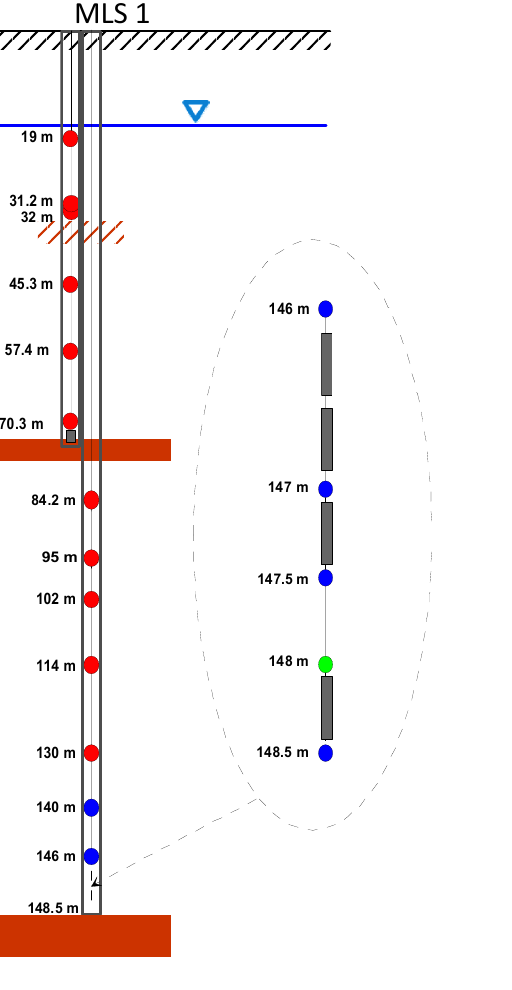
Fig. 3. Depth in meters below ground level (mb.g.l.) showing the positioning of the multilevel sampling (MLS) units in the two campaigns. Blue – 1 cell per depth (major ion and trace element analysis), green – 2 cells per depth and red – 3 cells per depth (major ion, trace element and volatile organic compound analyses). The dotted inset denotes details of the MLS below 145m. Gray rectangles resemble weights that were inserted in the bottom of the chain of sampling cells to lead it down the